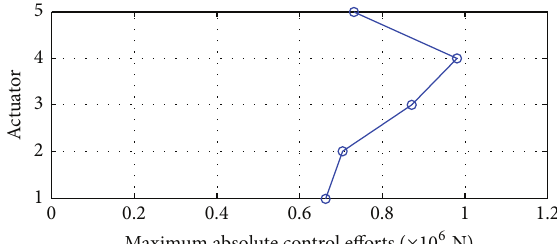
Figure 2: Full scale North-South El Centro 1940 seismic record.